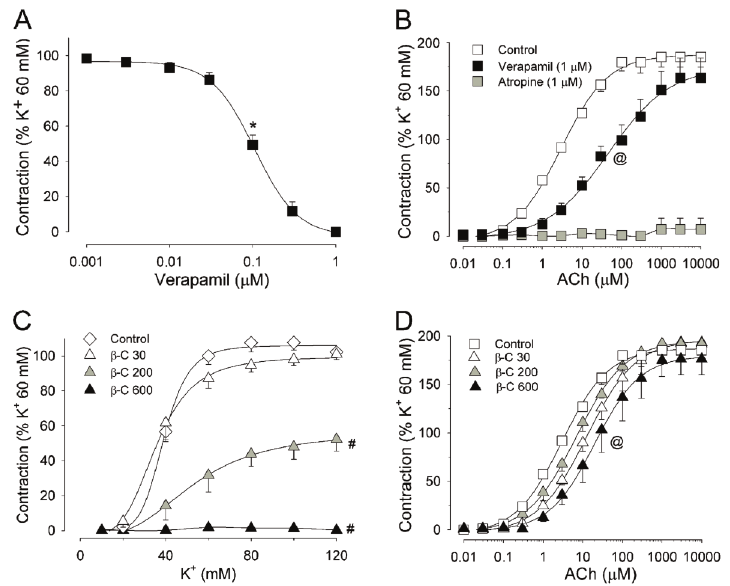
Figure 2. b -Citronellol preferentially inhibited the concentration-effect curves induced by high K + concentrations in isolated rat trachea. Panel A shows the concentration-effect curve that deter- mined 1 m M to be the verapamil concentration that could fully relax a sustained contraction induced by 60 mM K + . *Indicates the smallest concentration of verapamil with a signi fi cant effect; P o 0.05, ANOVA followed by the Holm-Sidak test. In panel B , 1 m M verapamil only shifted to the right (indicated by @) the concentration-effect curve in response to in- creasing concentrations of acetylcholine (0.01 m M – 10 mM ACh). The maximal effect induced by ACh was decreased signi fi cantly neither by verapamil ( B ) nor by b -citronellol (30 – 600 m M b -C; panel D ), which produced only a similar rightward displacement of the concentration-effect curve of ACh (indicated by @). The positive control atropine fully inhibited the cholinergic response. Panel C shows the inhibitory effect of b -citronellol (30 – 600 m M) in the concentra- tion-effect curve induced by increasing concentra- tions of K + (10 – 120 mM). # P o 0.05 compared to control for the maximal effect, two-way ANOVA and Holm-Sidak